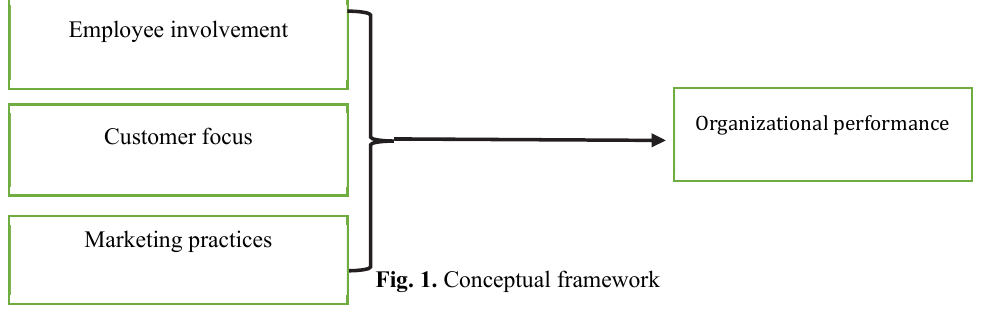
Fig. 1. Conceptual